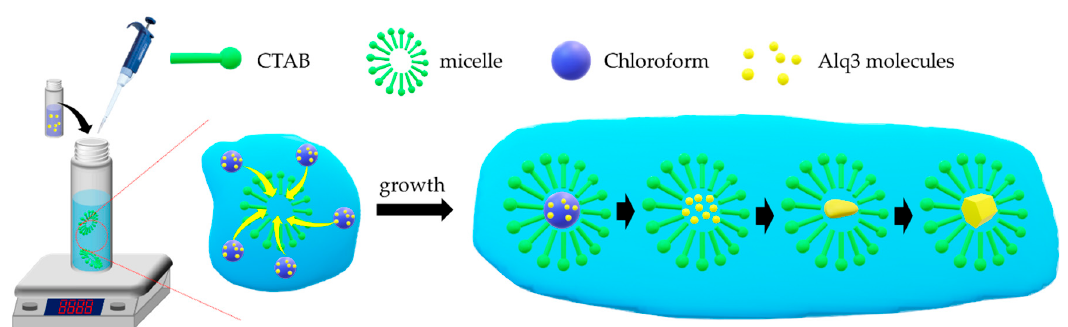
Figure 1. Schematic illustration of surfactant micelle-induced tris(8-hydroxyquinoline)aluminum(III) (Alq 3 ) micro-crystal (MC) growth. CTAB, cetyltrimethylammoniumbromide.